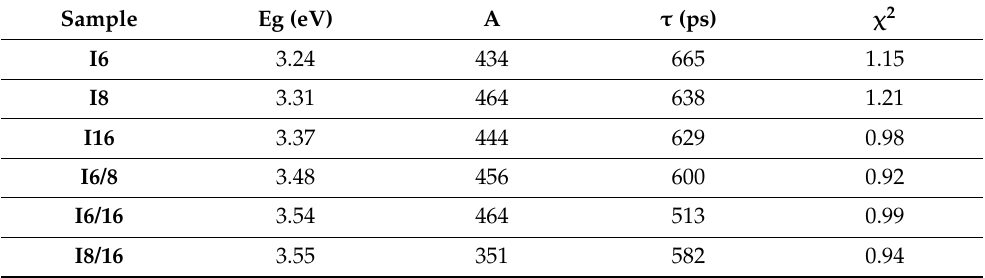
Table 2. The optical parameters evaluated from absorbance and fitting of time-resolved fluores- cence spectra.